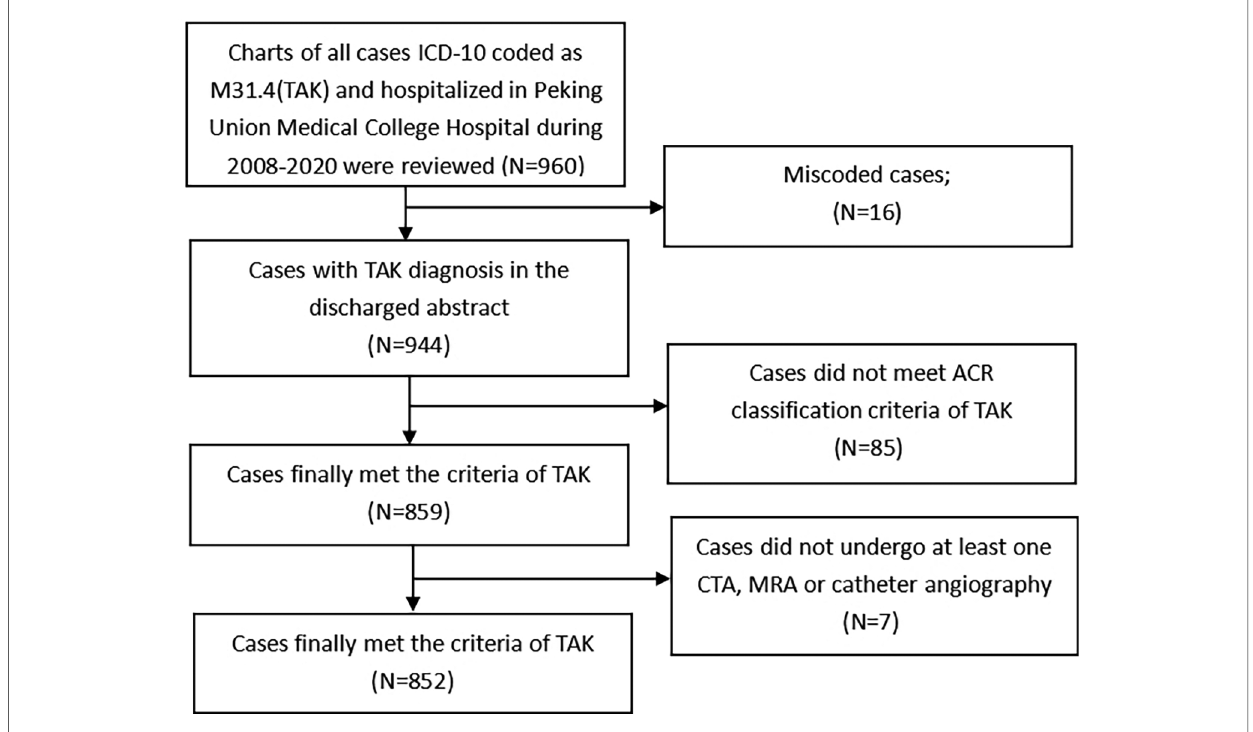
FIGURE 1 The fi nding strategy for recruiting the TAK patients in this study. Legend: This fi gure indicates the fl ow chart of the patients included in our